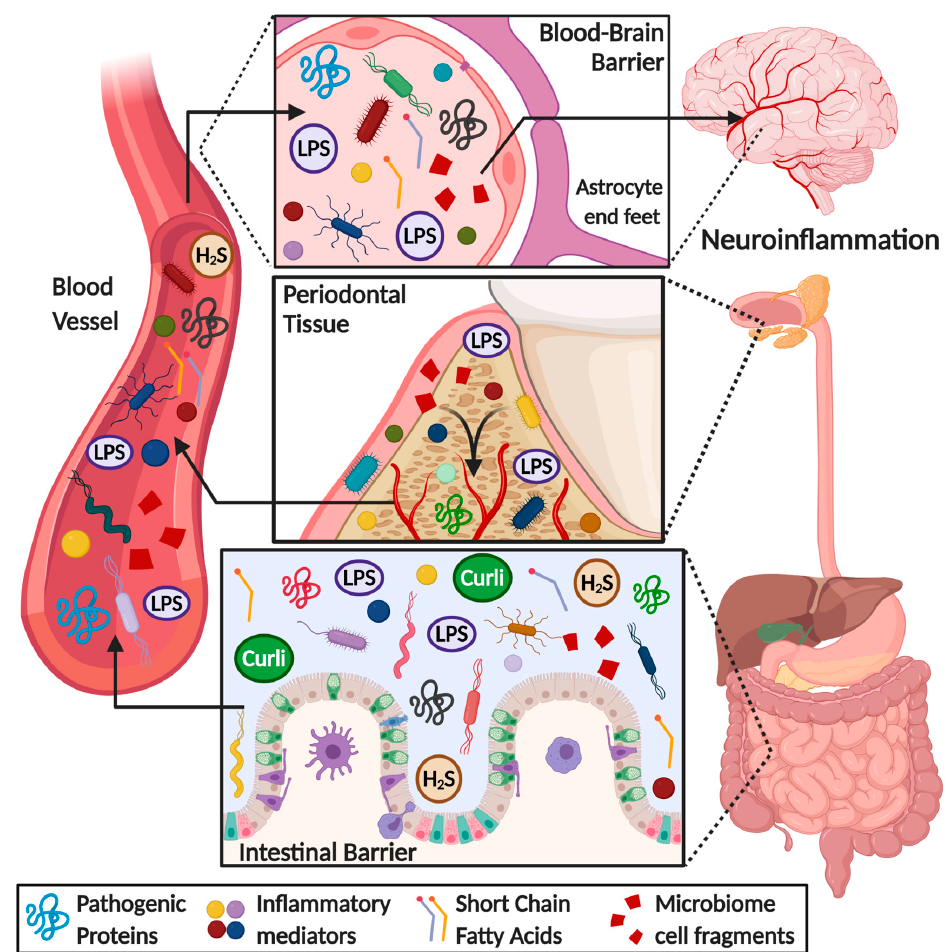
Figure 1. Overview of the role of gut and oral microbiome in the onset of neuroinflammation in neurodegenerative diseases. Some microbial products, such as lipopolysaccharide (LPS), short